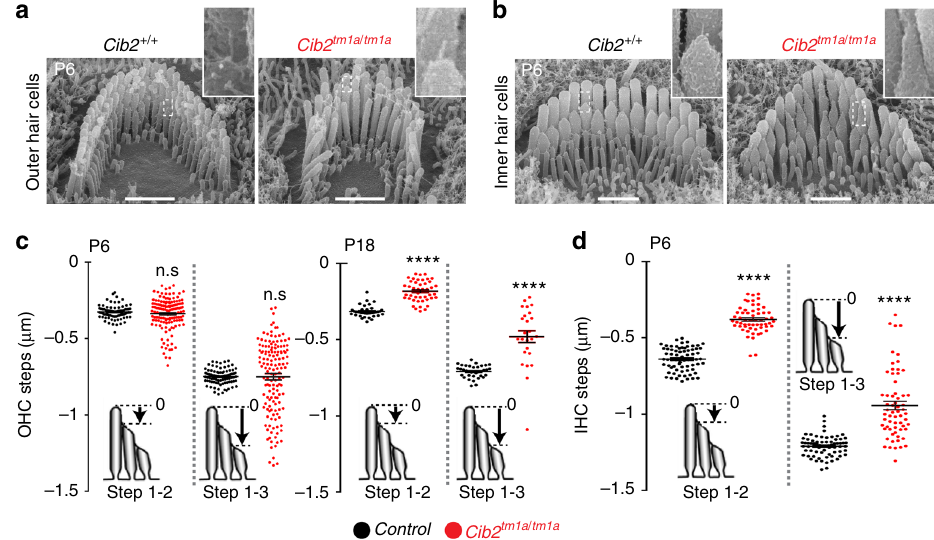
Fig. 4 CIB2 de fi ciency leads to over-elongation of the transducing shorter row stereocilia in the auditory hair cells. a , b SEM images of OHC ( a ) and IHC ( b ) bundles from wild-type ( left ) and Cib2 tm1a/tm1a ( right ) littermate mice at P6 at the same cochlear location in the middle of the apical turn. Insets show magni fi ed images of stereocilia tips and stereocilia links in the areas indicated by dashed boxes . c , d Quanti fi cation of the step height differences between the 1st (longest) and 2nd and between the 1st and 3rd rows of stereocilia (illustrated on the inset cartoons ) in the OHC ( c ) and IHC ( d ) bundles at P6 ( c , left and d ) and P18 ( c , right ). Each dot represents one pair of stereocilia. Mean ± SEM values are also shown. We were not able to quantify the staircase morphology in the IHCs at P18 because mouse IHCs are very fragile at this age and their bundles lose cohesiveness after dissection. Number of cells: IHCs, wild-type, n = 6; Cib2 tm1a/tm1a , n = 6; OHCs at P6, wild-type, n = 9; Cib2 tm1a/tm1a , n = 18; OHCs at P18, wild-type, n = 10; Cib2 tm1a/tm1a , n = 10. In all panels, asterisks indicate statistical signi fi cance of the difference between the data from mutant and wild-type cells. NS, not signi fi cant; **** p < 0.0001 (ANOVA). Scale bars: 1 μ m